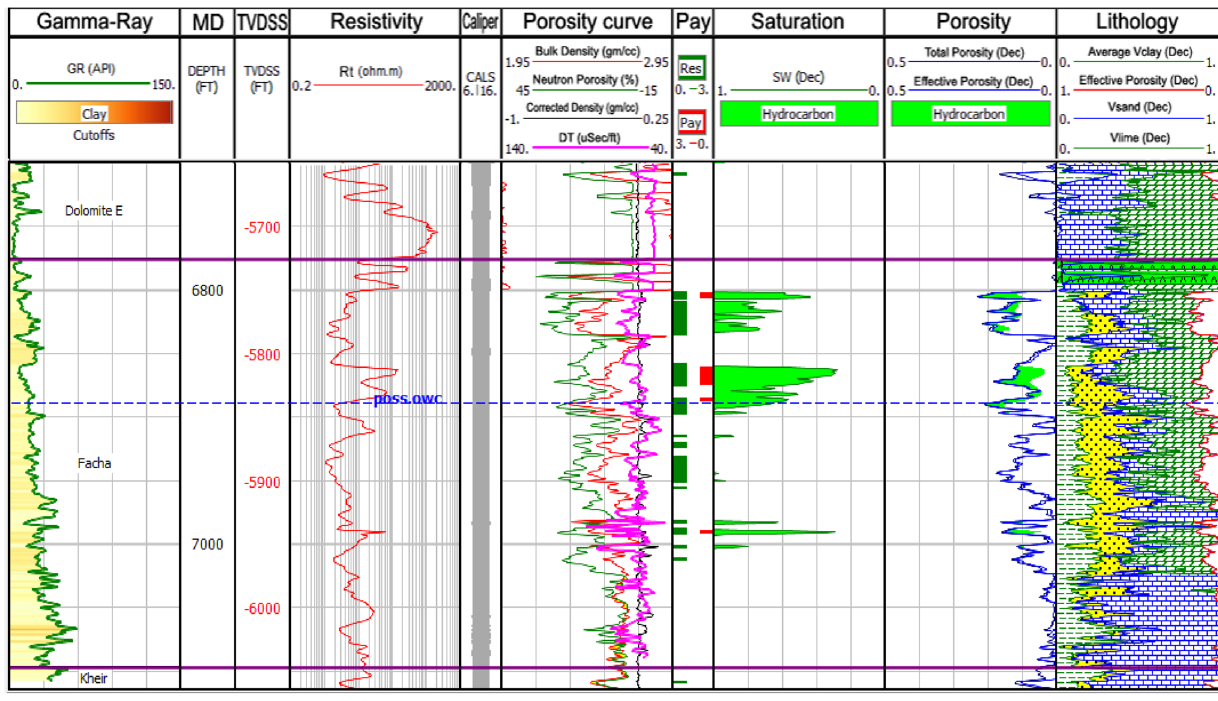
Fig. 10 Litho-saturation log plot of A13 well (as example), Facha reservoir Fig. 11 Structure contour map of the Facha